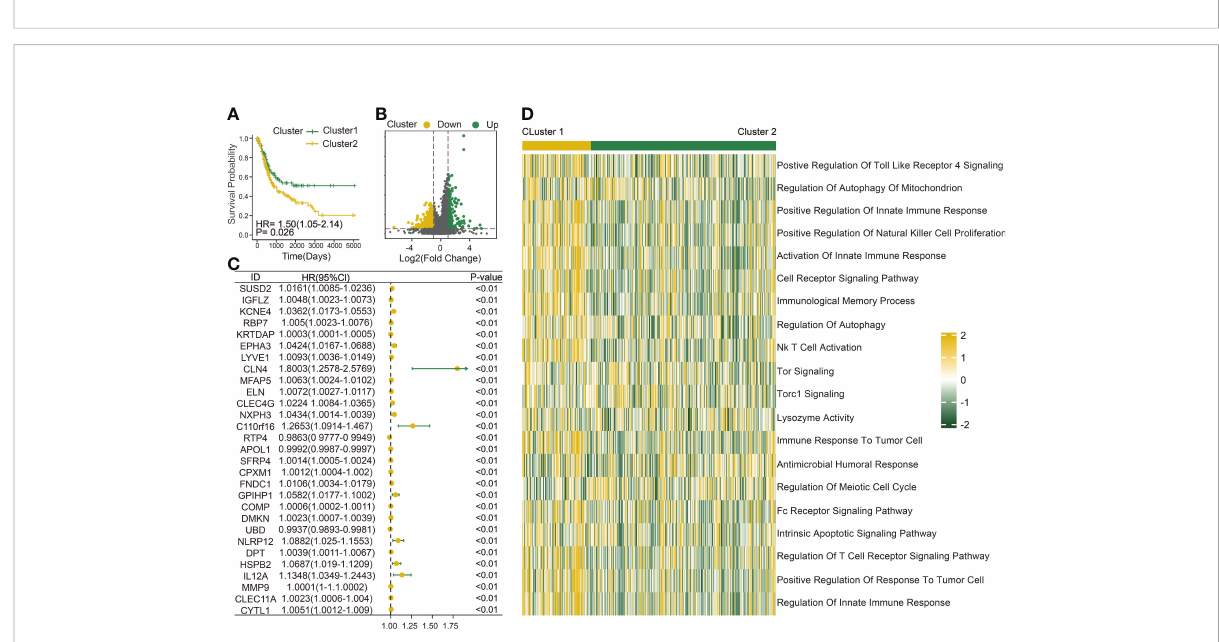
FIGURE 2 Construction of a DC-related risk model to predict BLCA prognosis. (A) Survival analysis of Cluster 1 (n = 110) and Cluster 2 (n = 294). (B) Volcano map shows 429 genes differentially expressed between Cluster 1 and Cluster 2. Green dots indicate upregulation and yellow dots indicate downregulation. (C) Univariate Cox regression analysis was used to screen genes associated with clinical prognosis with a p-value< 0.01 in the TCGA-BLCA cohort. (D) Gene set variation analysis (GSVA) enrichment analysis of the activation states of biological pathways between Cluster 1 (n = 110) and Cluster 2 (n = 294). These biological processes are shown in the heatmap. Yellow represents the activated pathway, and green represents the inhibited